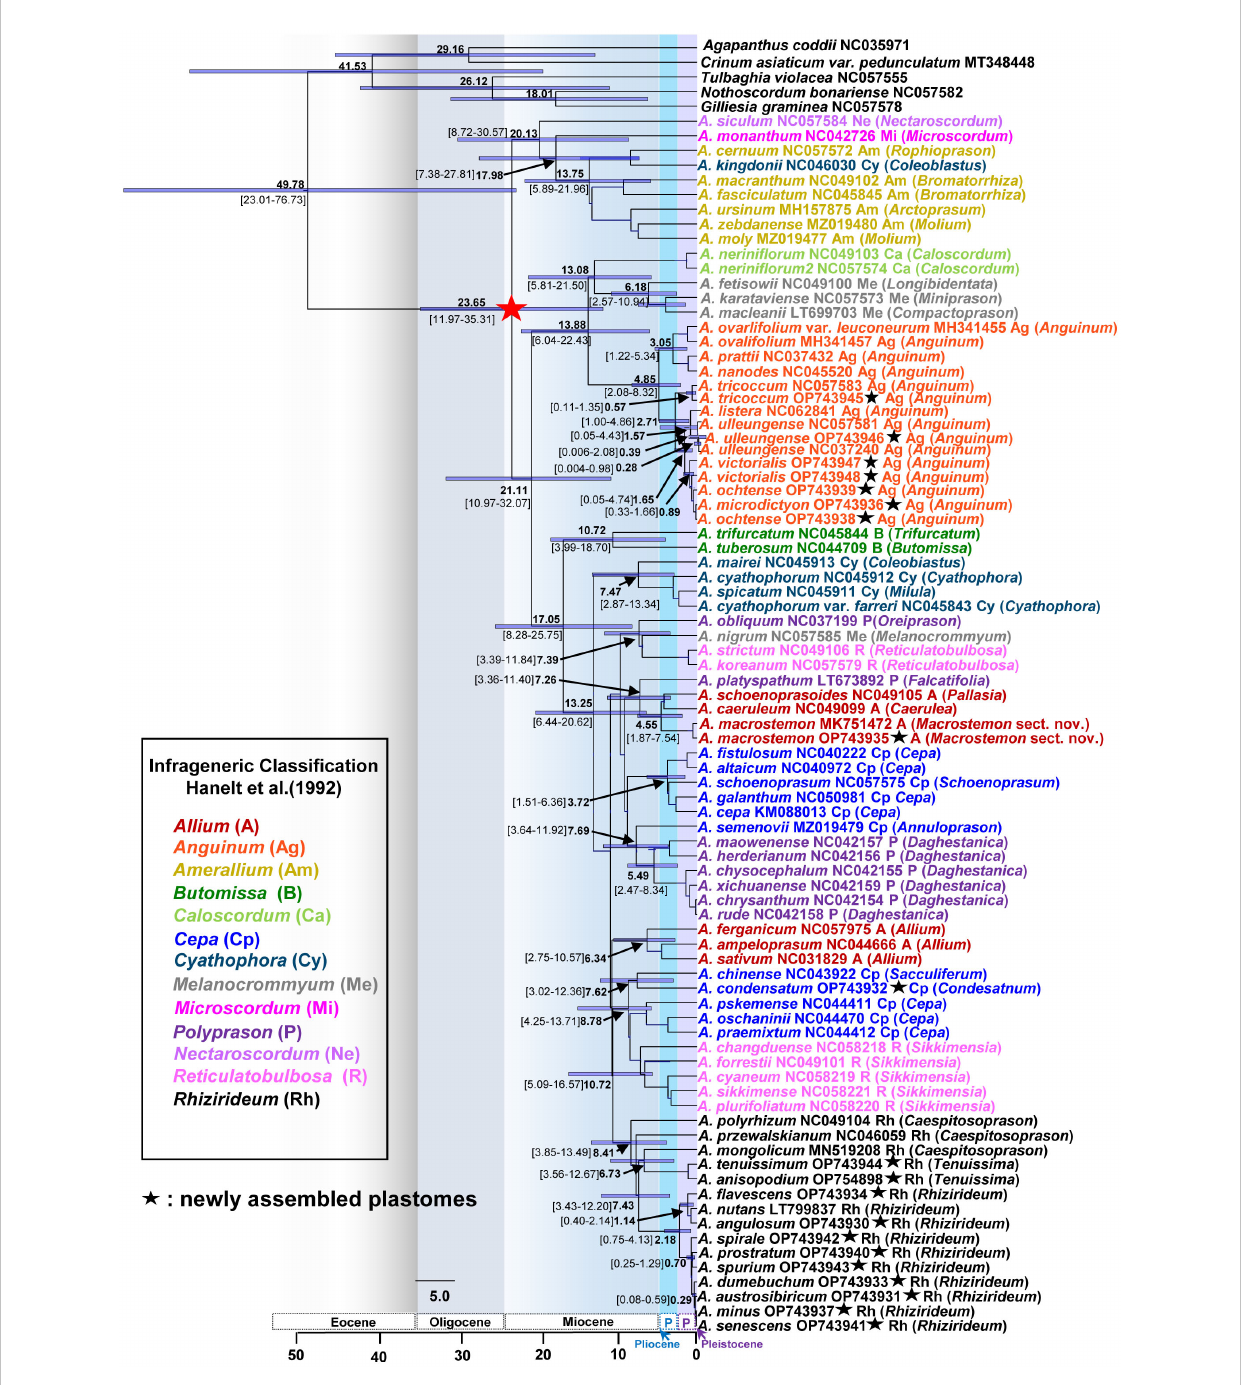
FIGURE 5 Dated chronogram showing divergence times of major lineages of the genus Allium , including three evolutionary lines identi fi ed previously. Estimated mean ages are shown in each node with 95% high posterior density (HPD) in bracket. The secondary calibration point estimated previously are shown as asterisked node (red star); that is, the crown age of the genus Allium was used in this study. Newly assembled plastome in this study is shown in black asterisk. Subgenera (Hanelt et al., 1992) are indicated in different colored labels. A species name is followed by an NCBI accession number, a subgeneric abbreviation, and a section in